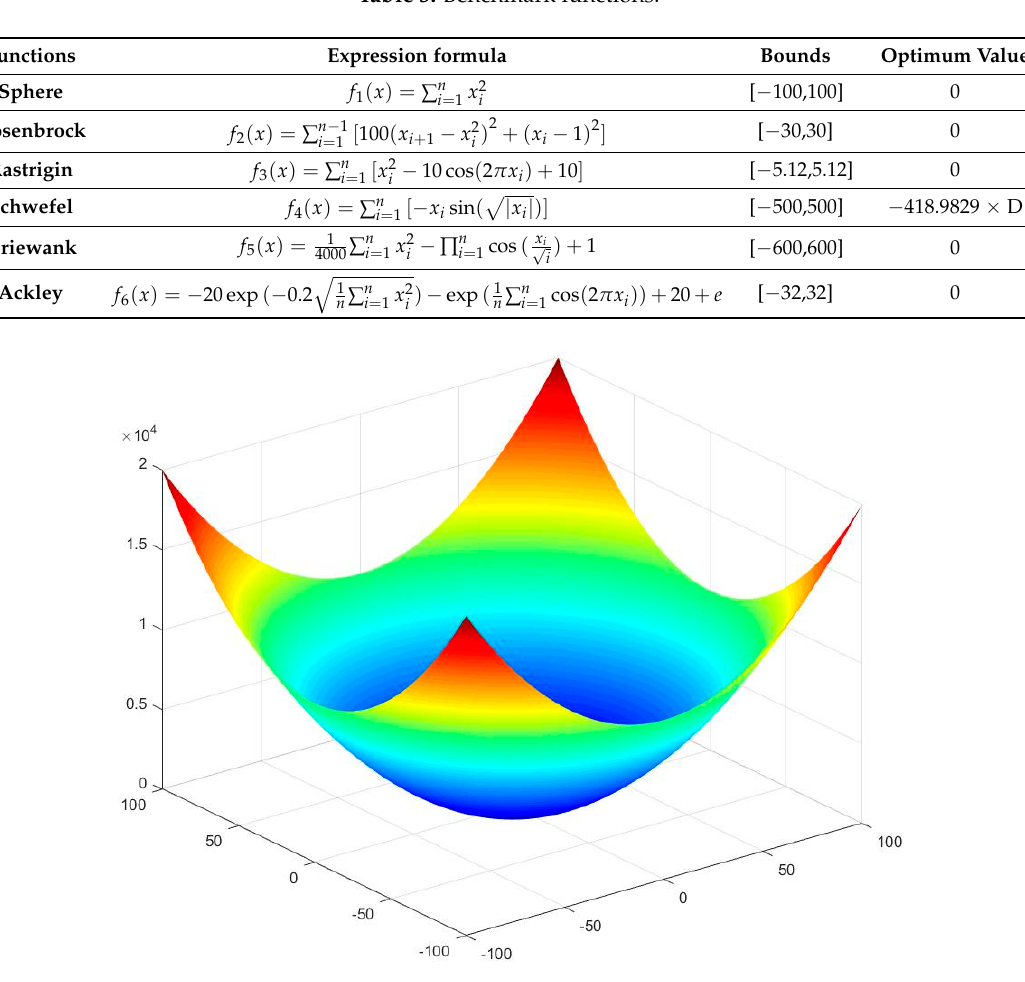
Figure 4. Three-dimensional image of Rosenbrock function ( f 2 ).